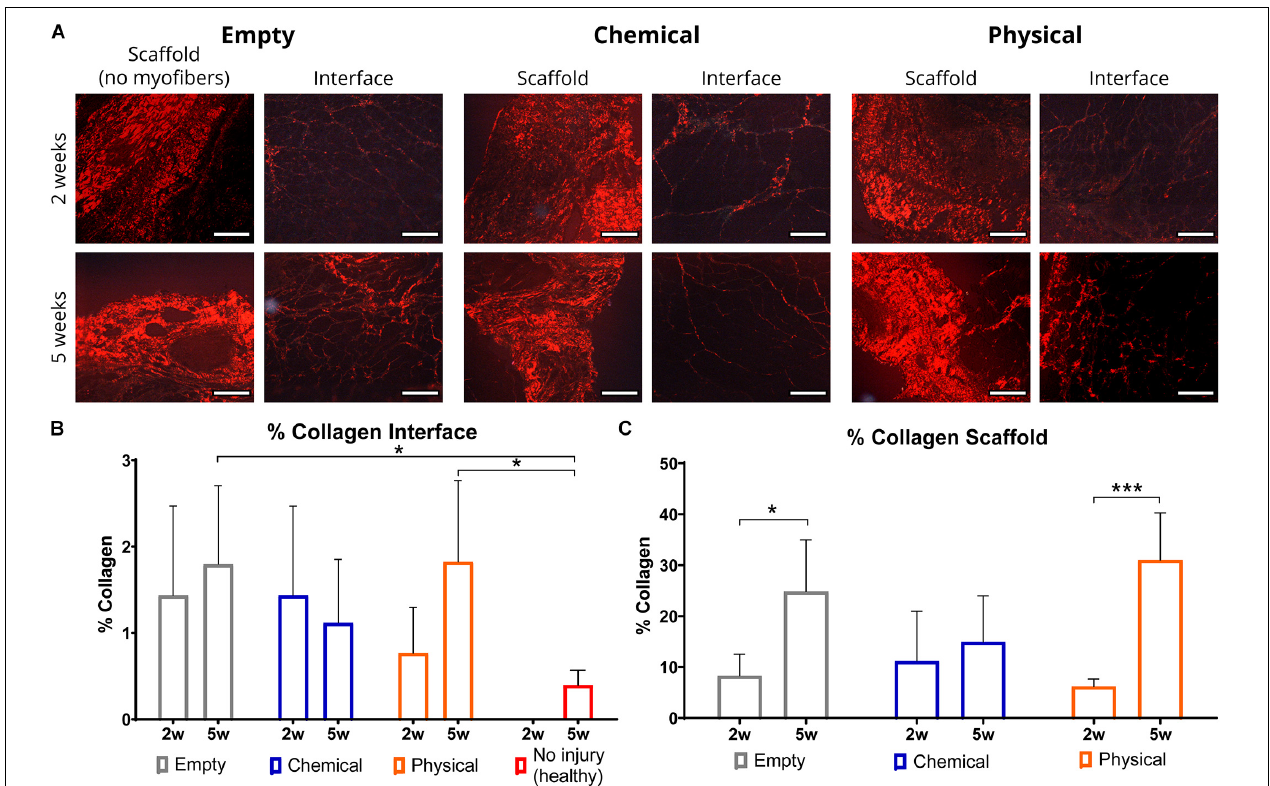
FIGURE 3 | Representative images and quantification for collagen staining with Picrosirius red. (A) Polarized light images from muscle samples of empty (left), chemical (center), and physical (right) groups for the scaffold (area without newly formed myofibers) and interface (area with newly formed myofibers) regions at 2 (top) and 5 weeks (bottom) post-injury. Scale bar = 100 µ m. (B,C) Percentage of collagen in the interface (including no injury group at 5 weeks) and scaffold regions, normalized to their areas, after 2 and 5 weeks. * p < 0.05, *** p <